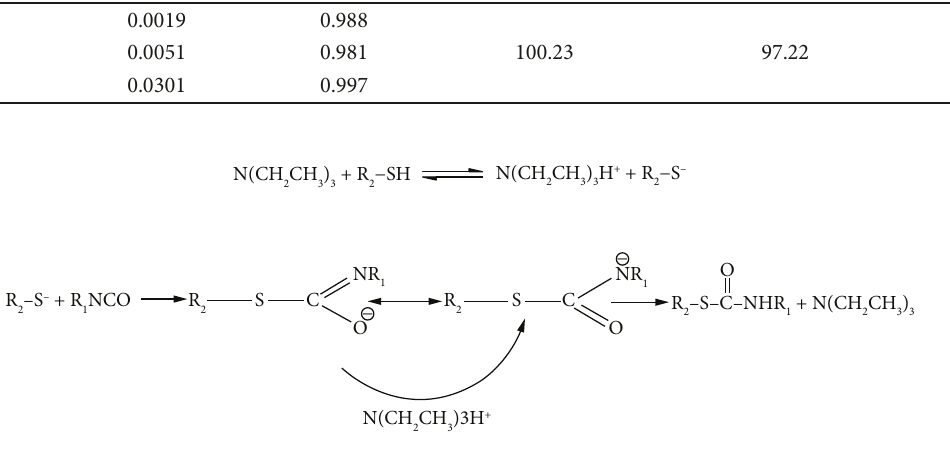
Figure 7: Mechanism of nucleophilic addition between isocyanate and thiol catalyzed by TEA.